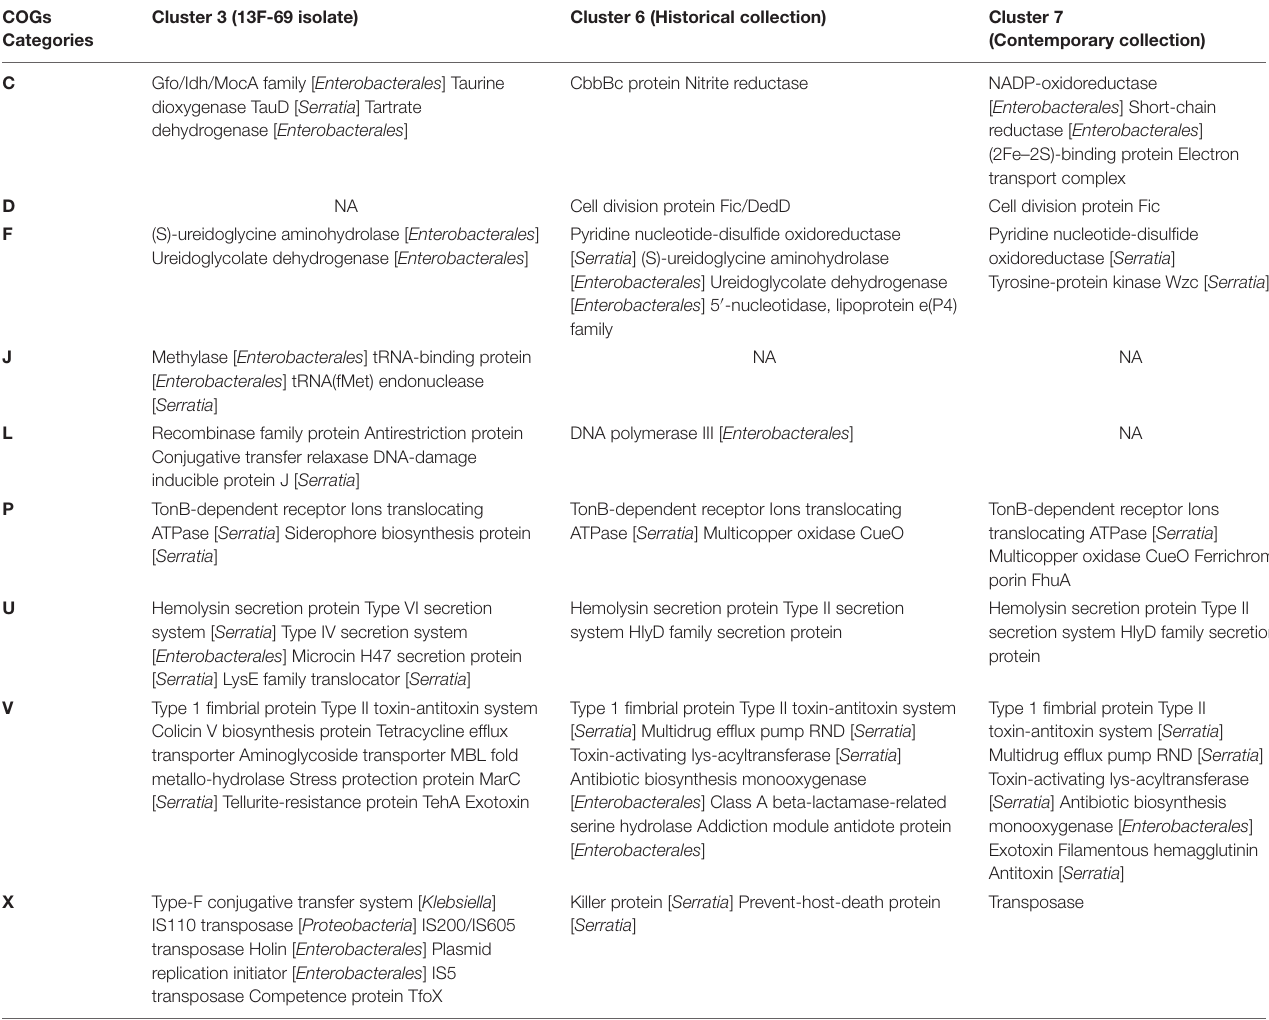
TABLE 7 | Top relevant proteins of the accessory genome that significantly explained the discrimination of each of the three clusters to which the eight Serratia marcescens studied strains belong to, with respect to the overall population, analyzed by AcCNET software. COGs